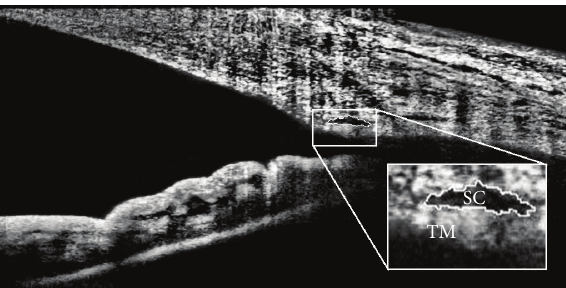
Figure 1: Visualization of outflow structures (SC, TM) with AS- OCT.Theimagewas adjusted tomaximize visualization withImageJ